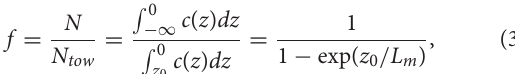
FIGURE 1 | Depth profile of normalized concentration of buoyant particles c / c 0 as a function of z / L m according to the wind-mixing model as described by Equation (2).